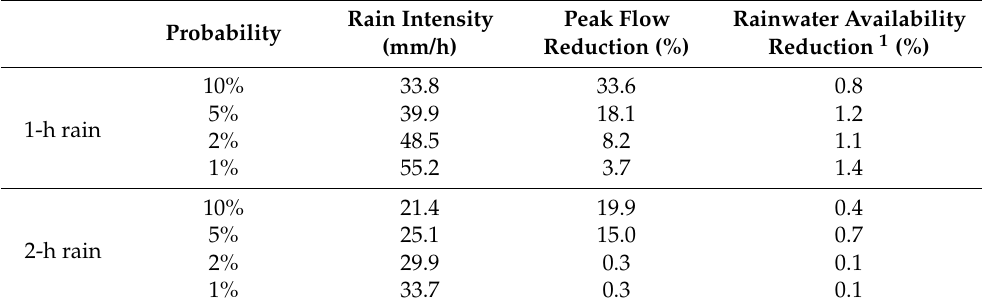
Table 4. Peak flow reduction and rainwater availability reduction due to implementing the optimized control release policy for each rain intensity for 1-h and 2-h rain.